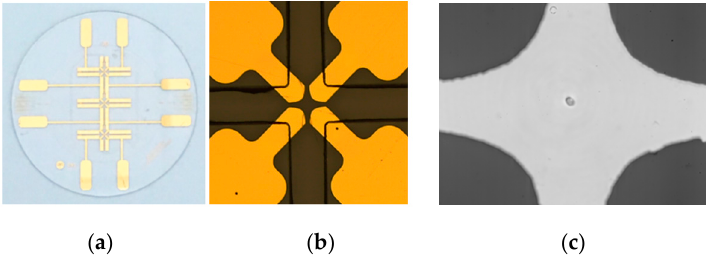
Figure 1. Microfluidic device for characterizing electrorotation of a microalgae cell: ( a ) the microelectrode design; ( b ) a close-up of the microelectrodes (gold) and the microchannels (black lines); ( c ) single microalgae cell ( Scenedesmus abundans ) captured at the center of the microelectrode